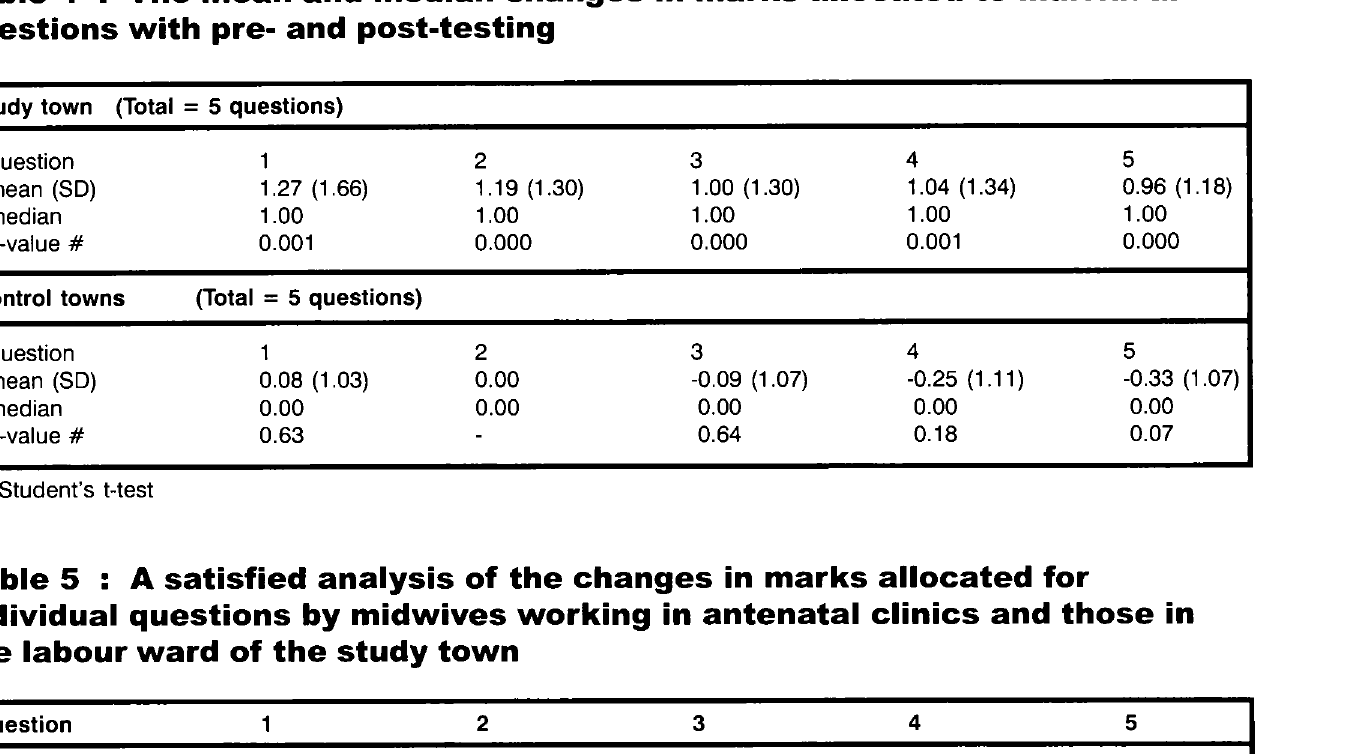
Table 5 : A satisfied analysis of the changes in m arks allocated for individual questions by midwives w orking in antenatal clinics and those in the labour w ard of the study town